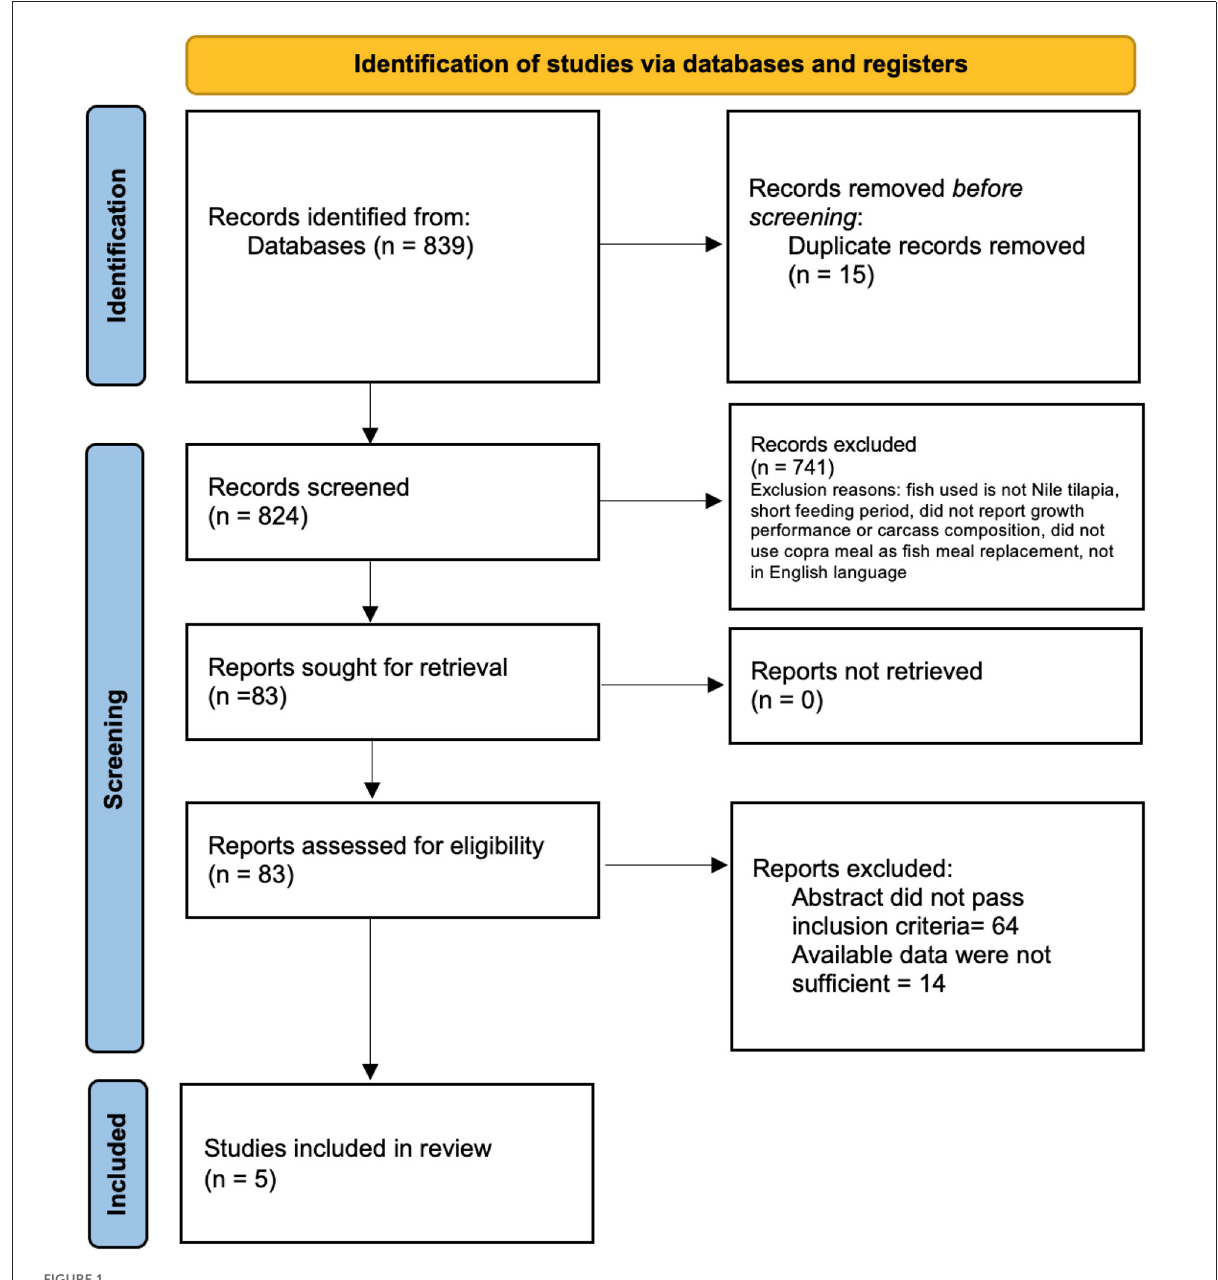
FIGURE1 Literature search and inclusion of related studies on copra meal as fishmeal replacement for Nile tilapia diet.